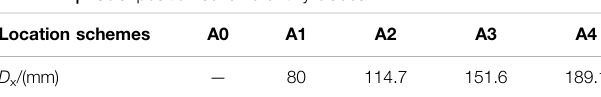
TABLE 1 | Radial position scheme of tiny blades.